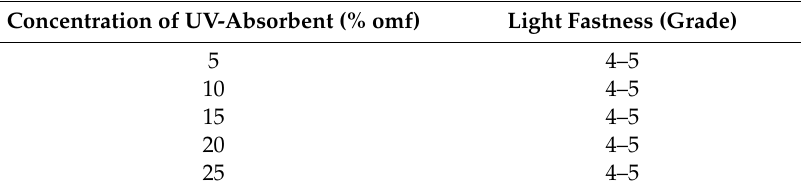
Table 2. Light colorfastness (KS K ISO 105 ‐ B02: 2014) of dyed fabrics according to the concentration of UV ‐ absorbent (5%–25% omf).